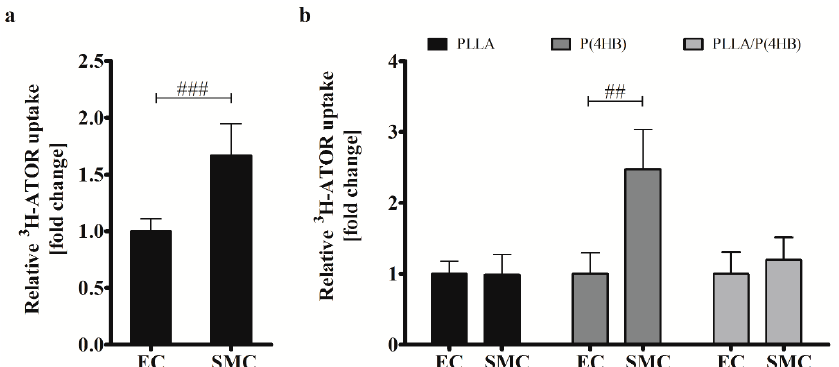
Table 1. IC 50 of ATOR on HCASMC and HCAEC grown on different polymer surfaces. IC 50 values were calculated from sigmoidal dose-response curves as the concentration of ATOR causing 50% reduction in cell growth. The 95% confidence intervals (CI) are